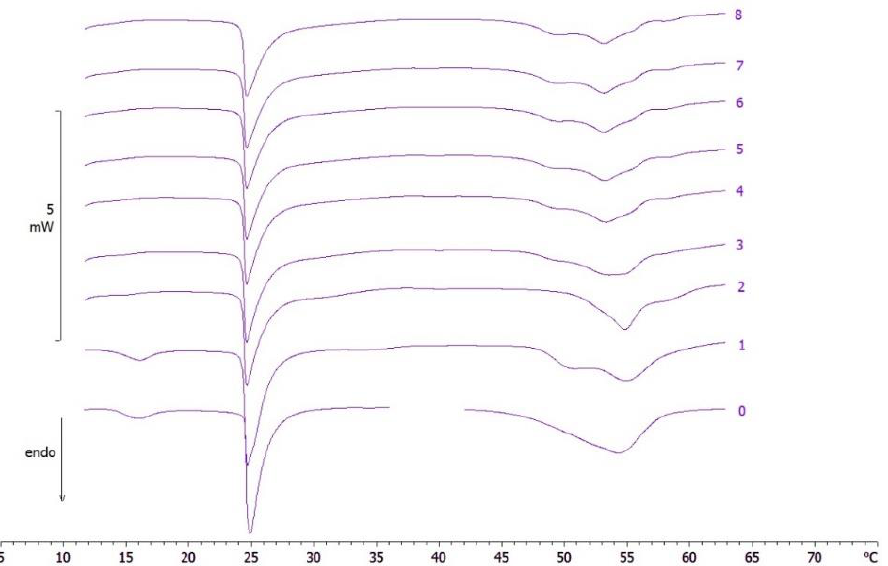
Figure 8. Calorimetric curves, in heating mode, of MLV put in contact with empty SLN, at pH 5, at increasing incubation time. The numbers on the right side of the curves refer to the calorimetric scans. The curves 0 refer to the samples before contact.